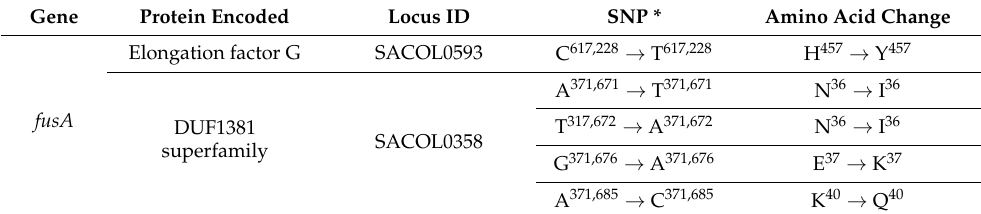
Table 1. SNPs identified by comparative genome sequencing in SH10001st-2.